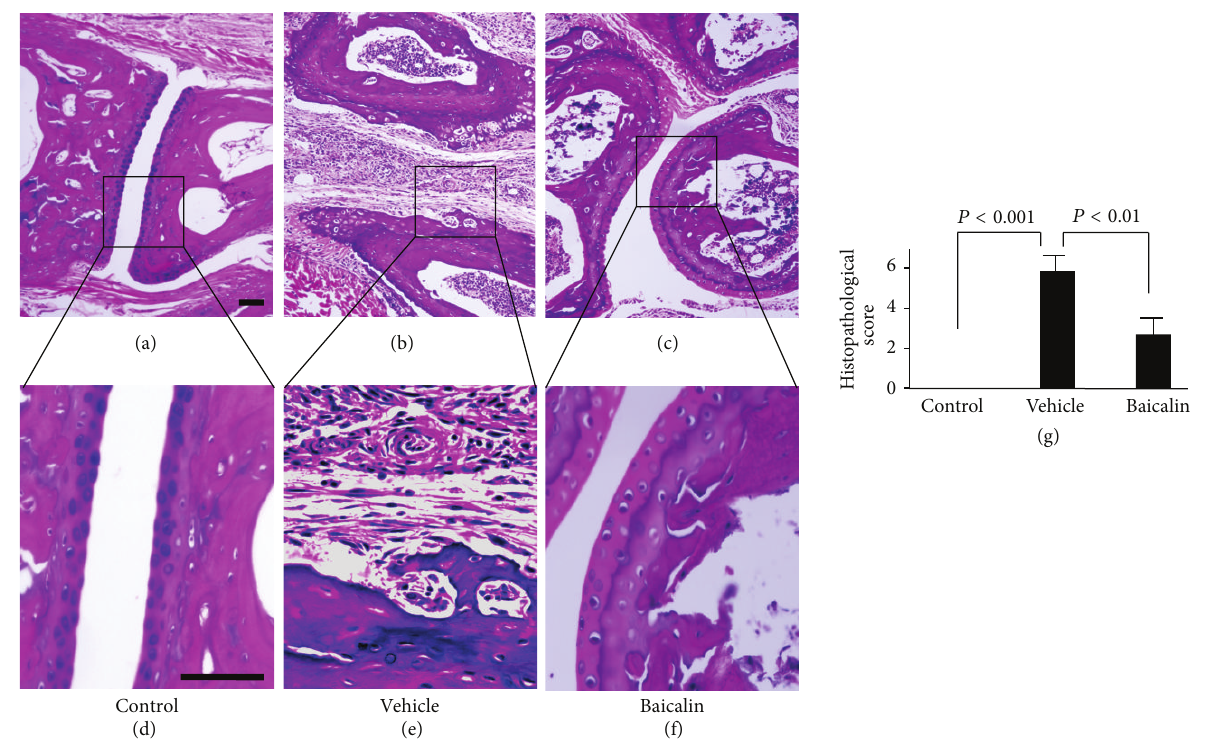
Figure 2: Baicalin inhibits ankle joint inflammation injury in adjuvant-induced arthritis mice. Adjuvant-induced arthritis mice were injected intraperitoneally daily with 100 mg/kg Baicalin or phosphate-buffered saline (vehicle control) for 1 week. Hematoxylin and eosin staining of control mice (a), adjuvant-induced arthritis mice with vehicle control treatment (b), and adjuvant-induced arthritis mice with Baicalin treatment (c). Further magnification of the black-bordered box showed the typical inflammatory injuries in control mice (d), adjuvant-induced arthritis mice with vehicle control treatment (e), and adjuvant-induced arthritis mice with Baicalin treatment (f). (g) Histopathological scores of the joint tissues ( 𝑛 = 6 for each